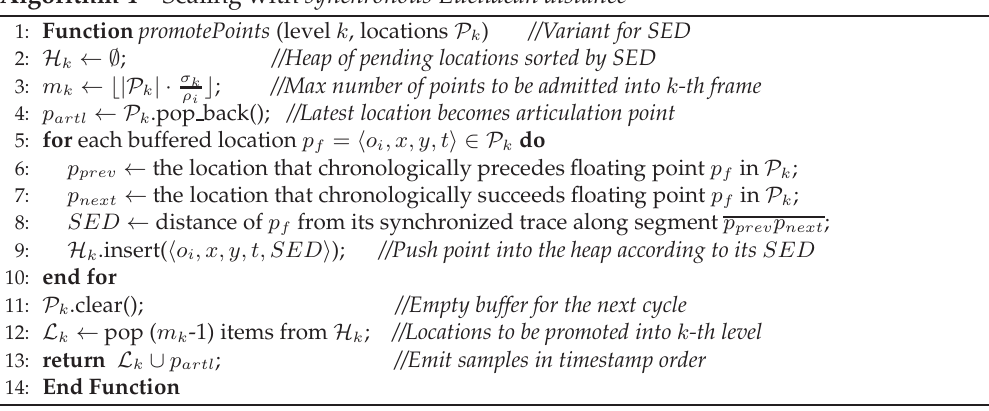
Algorithm 4 Scaling with synchronous Euclidean